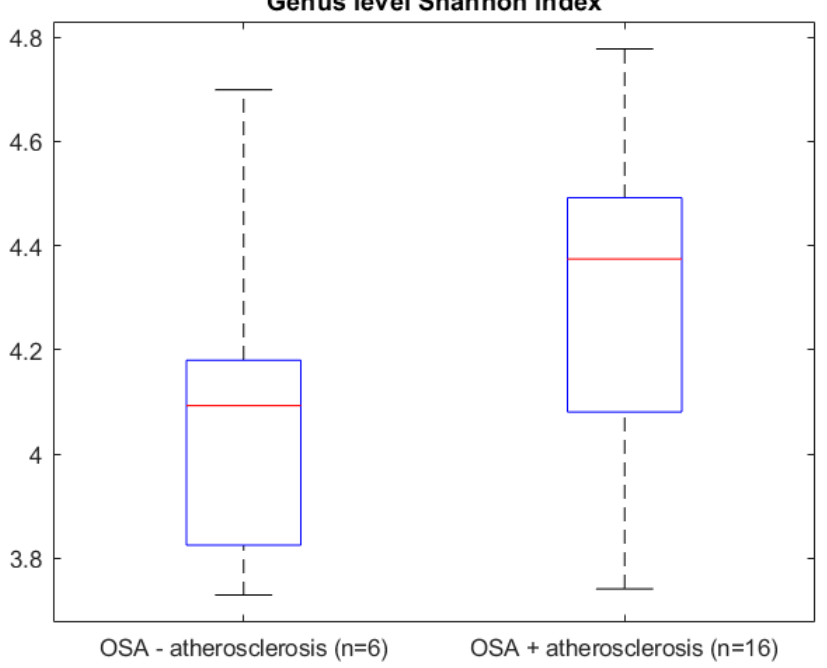
Figure 3. Wilcoxon rank sum test between the genus level Shannon indexes of the groups.